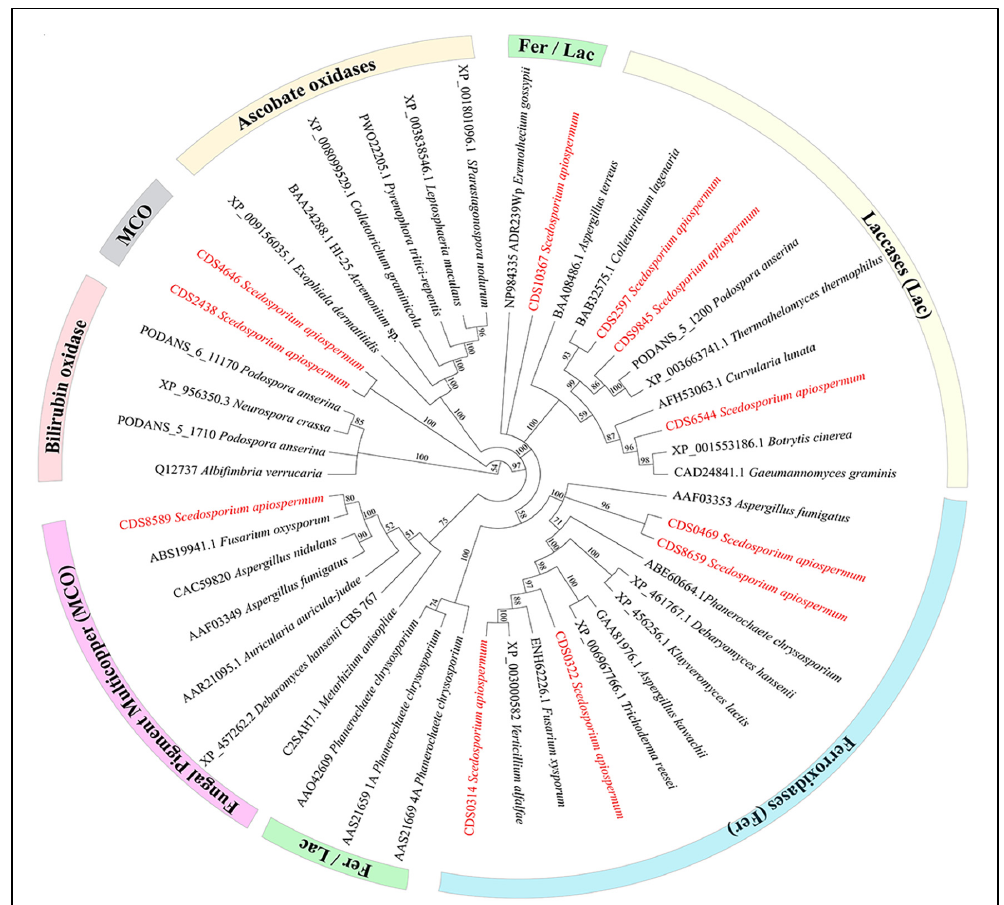
Figure 6. Classification of candidate enzymes among fungal MCO. An alignment of the protein sequences was created using the default settings for multiple alignments. Phylogenetic trees were constructed by the neighbor-joining method with cladogram presentation. Bootstrapping was carried out with 500 replications. Ferroxidases (Fer) are colored in blue, Laccases (Lac) in light yellow, Ferroxidases/Laccases (Fer/Lac) in green, Ascorbate oxidases in light orange, Multicopper oxidases (MCO) in grey, Bilirubin oxidase in dark orange and Fungal pigment multicopper in purple. Genes studied within Scedosporium species are marked in red.